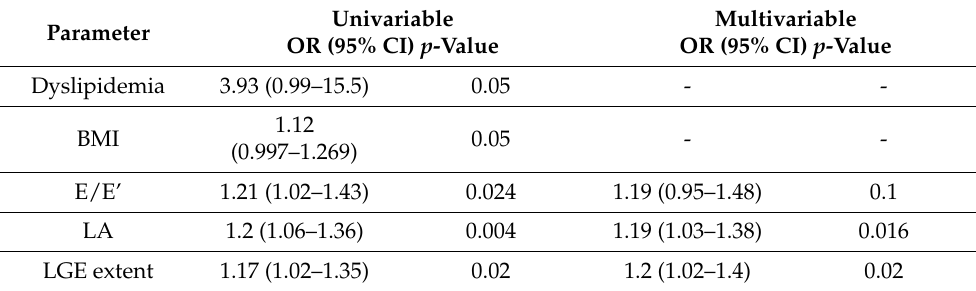
Table 3. Uni- and multivariable regression models for nsVT